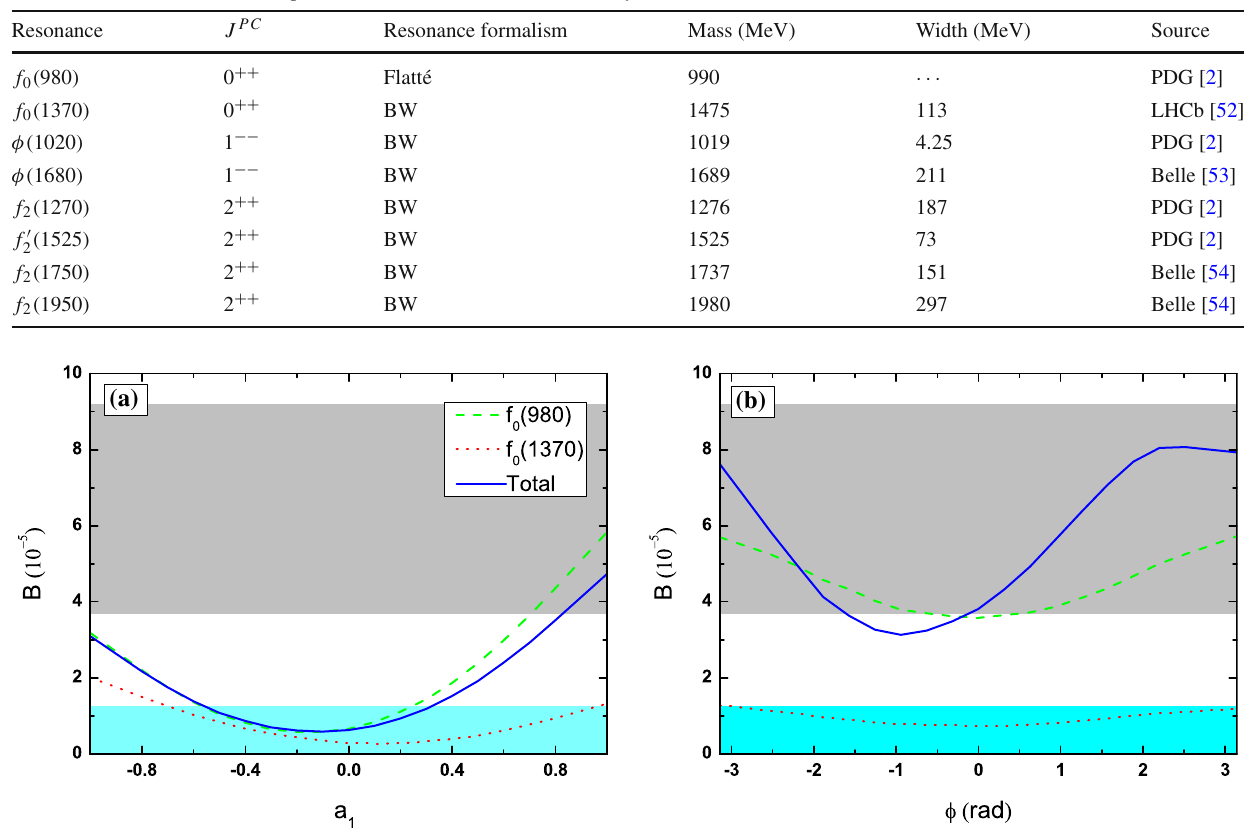
the f 0 ( 980 ) , f 0 ( 1370 ) , and their combinatorial contributions, respec- tively. The gray and cyan shaded bands are corresponding to the current experimental constraint of the f 0 ( 980 ) and f 0 ( 1370 ) modes from the LHCb [1],